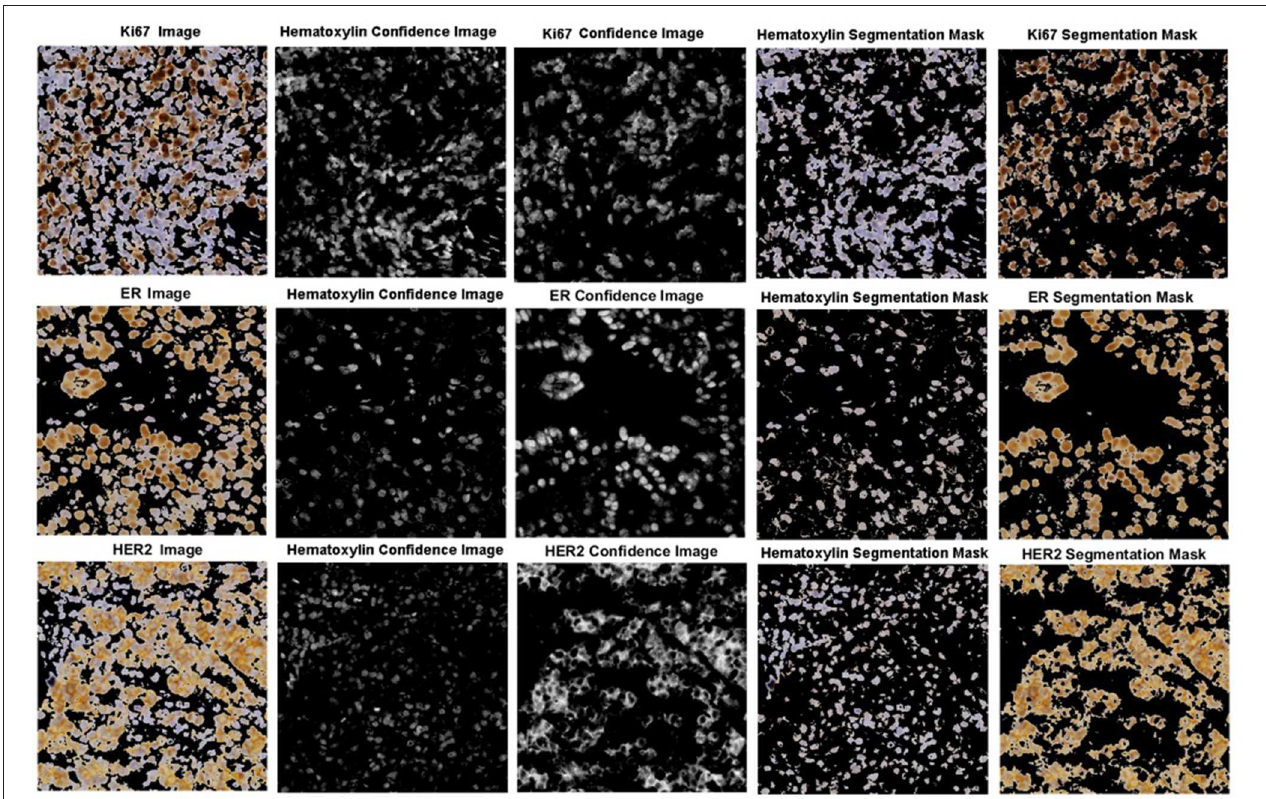
FIGURE 13 | Color separation framework applied to Ki67, ER, and HER2 images with associated confidence and color separated images.